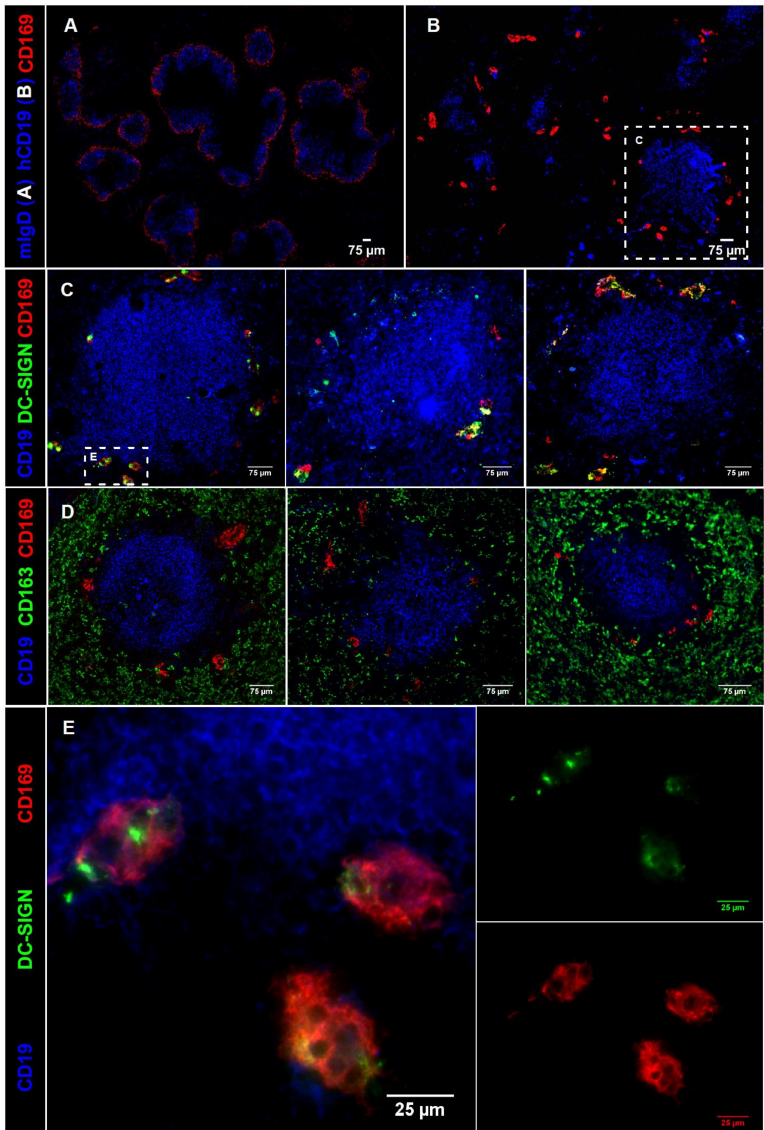
Figure 3. CD169 expression in mouse and human spleen. ( A ) Mouse spleen overview section stained for IgD (blue) and CD169 (red). ( B ) Human spleen overview section stained for CD19 (blue) and CD169 (red). ( C ) B cell follicles (blue) in human spleen from three different donors, CD169 + cells (red) and DC-SIGN + cells (green). The first panel is a zoom-in from ( B ). ( D ) B cell follicles (blue) in human spleen from three different donors, CD169 + cells (red) and CD163 + cells (green). ( E ) zoom-in from first panel of ( C ). 2.4. Ab Binding to CD169 and DC-SIGN on MoDCs Induces Uptake and